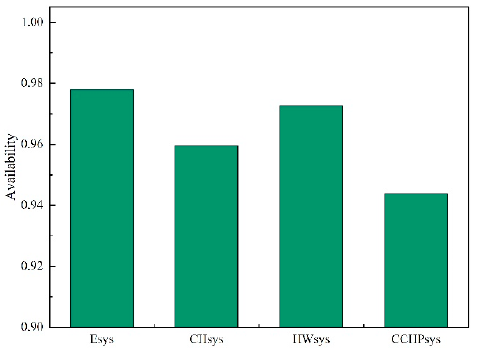
Figure 11. The availability of the systems of the CCHP system at KSRP.